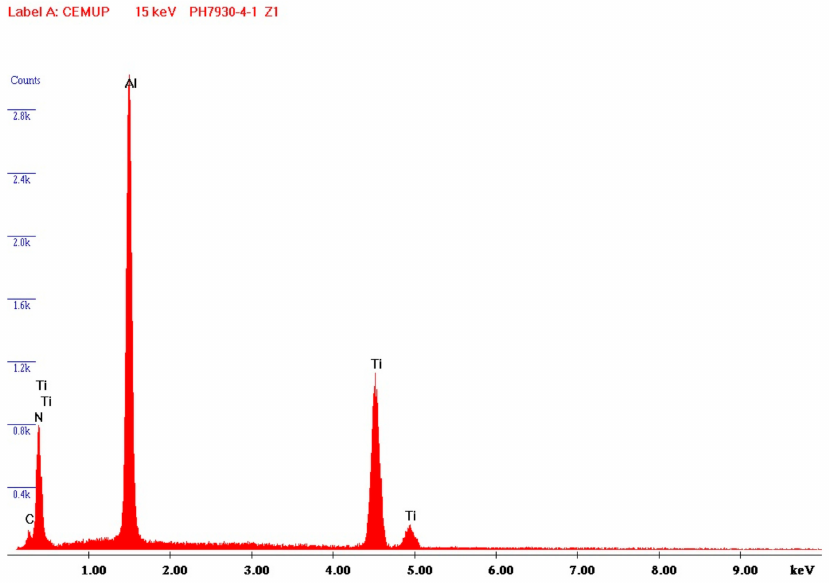
Figure 8. EDS spectrum of the Zone 1 pointed out in the SEM image of Figure